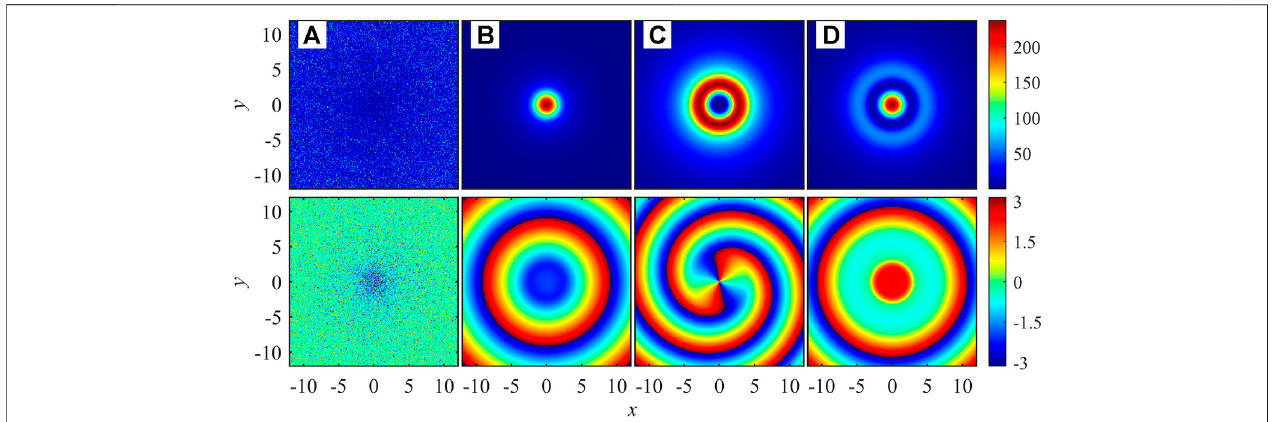
(cid:3)(cid:3)(cid:3)(cid:3) φ ( x , y )| 2 (upperpanels) andphasedistributions θ ( x , y ) (lowerpanels) ofsteadystatessimulatedby Eq.1 at t (cid:2) 400 FIGURE2| (Coloronline)Polaritonsdensity with the decay ratio c c / c R (cid:2) 0 . 1. (A – D) : Pumping radius R (cid:2) 1 , 3 , 5 . 2 , 8, corresponding to locations marked by triangles of I from bottom to up in Figure 1 , respectively.